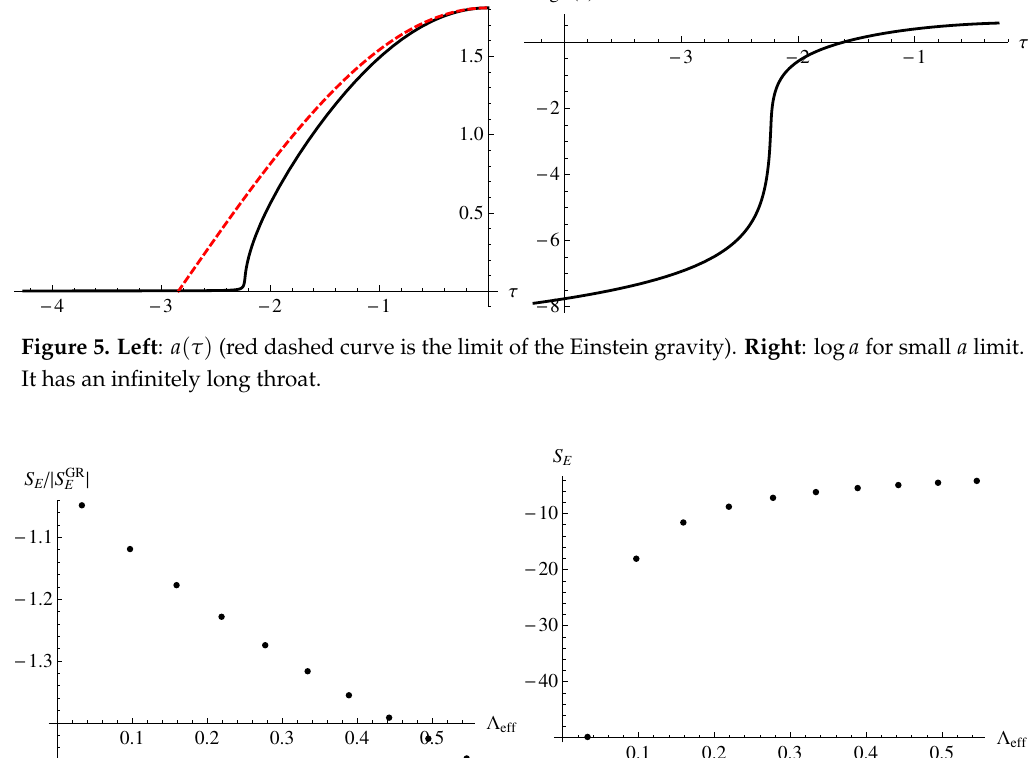
= 0.1 by varying Λ (equivalently, varying Pl